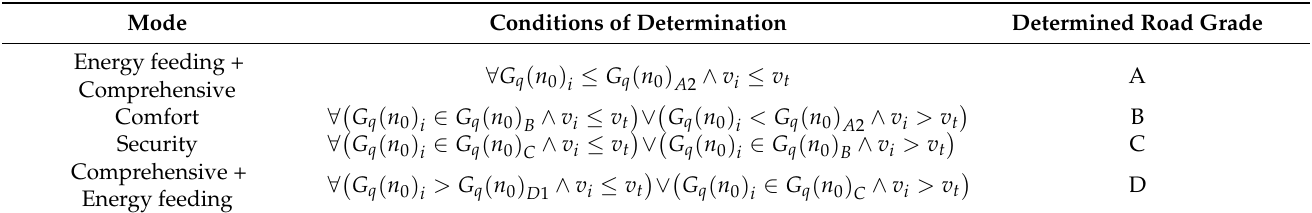
Table 3. Multi-mode switching decision rules.